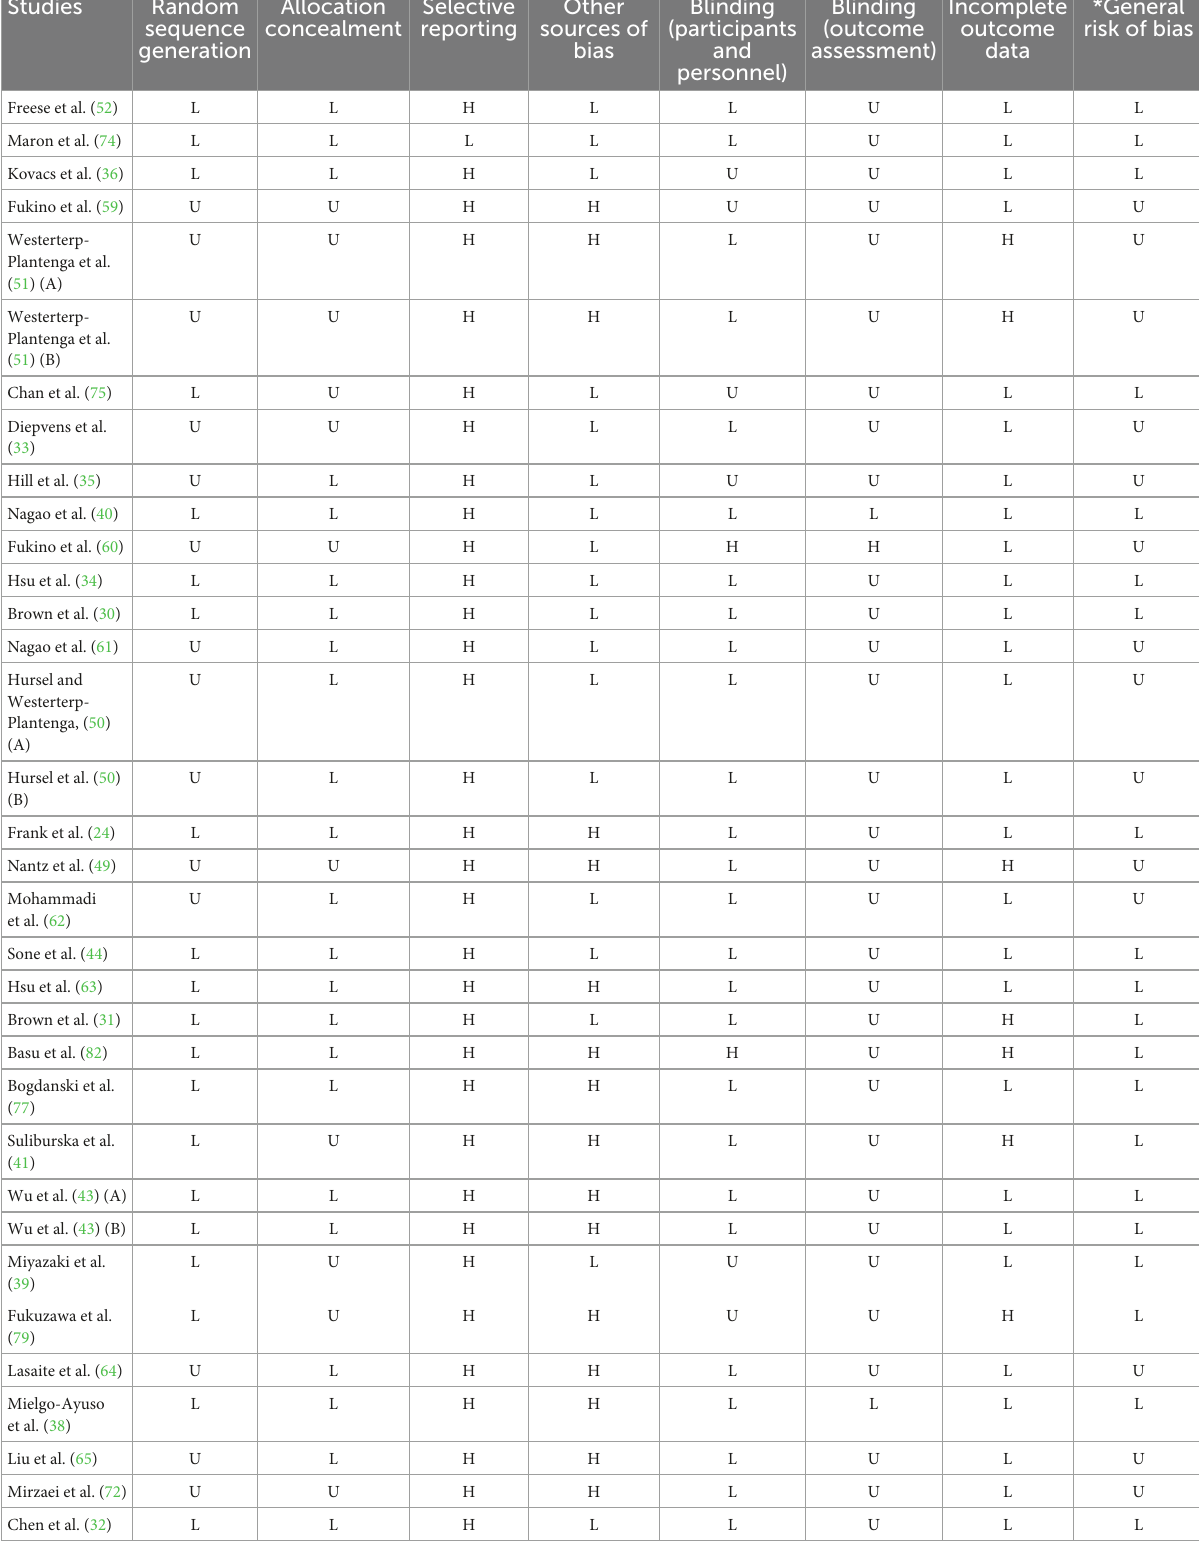
TABLE 2 Risk of bias